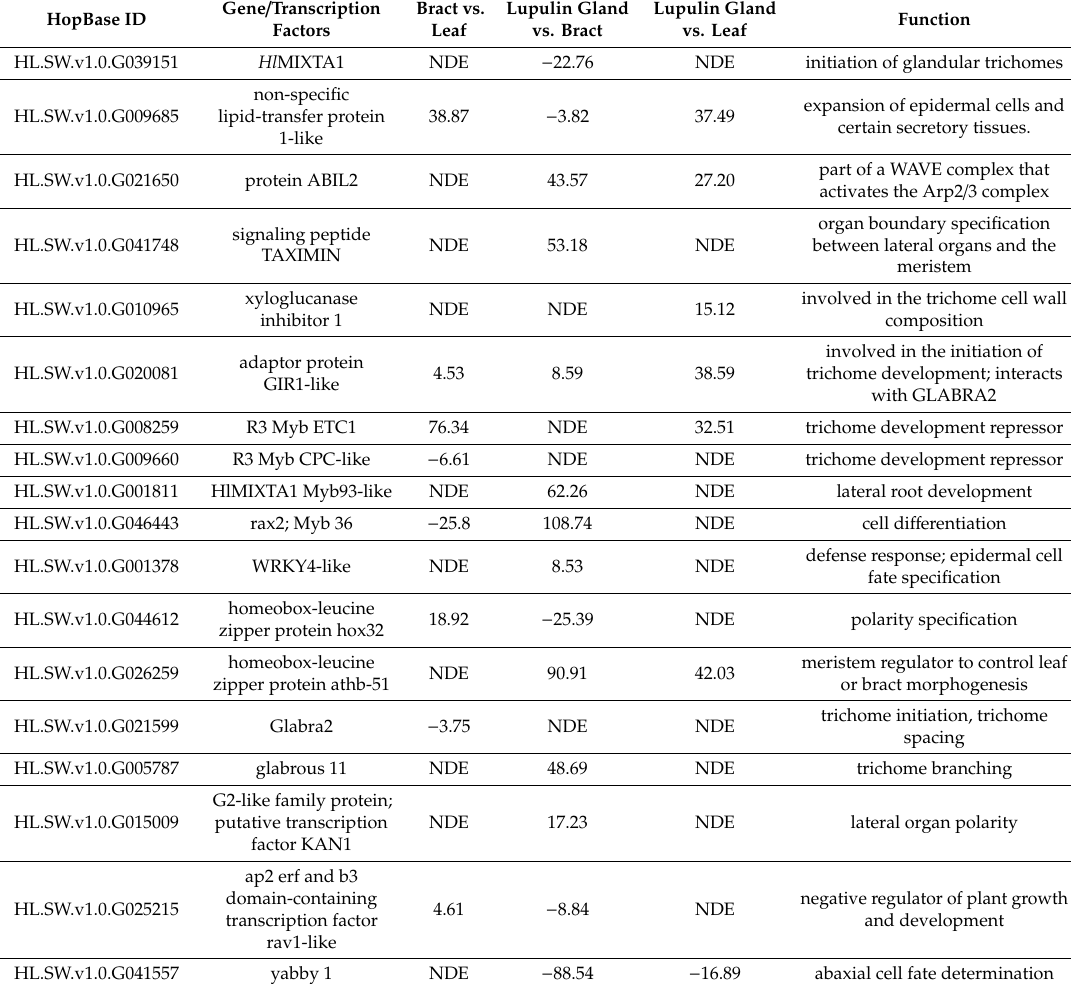
Table 4. The list of identified di ff erentially expressed genes and transcriptional factors with their plausible involvement in trichome